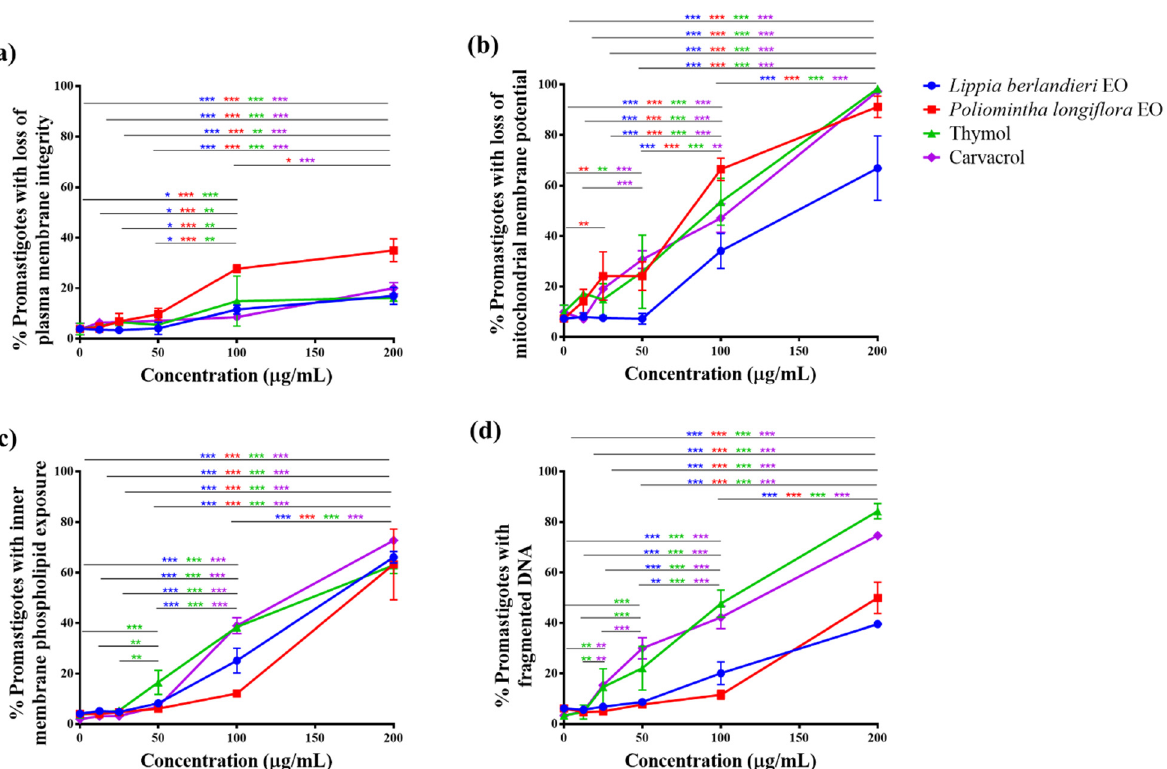
Figure 4. Characterization of the effect induced on Leishmania mexicana promastigotes by Lippia berlandieri EO, Poliomintha longiflora EO, thymol, and carvacrol. Parasites were treated with 0, 12.5, 25, 50, 100, and 200 µg/mL of EOs, thymol, or carvacrol; incubated for 24 h; and stained and analyzed by flow cytometry. ( a ) Loss of plasma membrane integrity, ( b ) loss of mitochondrial membrane potential, ( c ) inner membrane phospholipids (PL) exposition, and ( d ) DNA fragmentation. Data represent the mean and SD of three experiments. Statistical comparison was performed with two-way ANOVA (concentration x effect) with Tukey’s multiple comparison test, * p ≤ 0.05, ** p ≤ 0.01, and *** p ≤ 0.001.